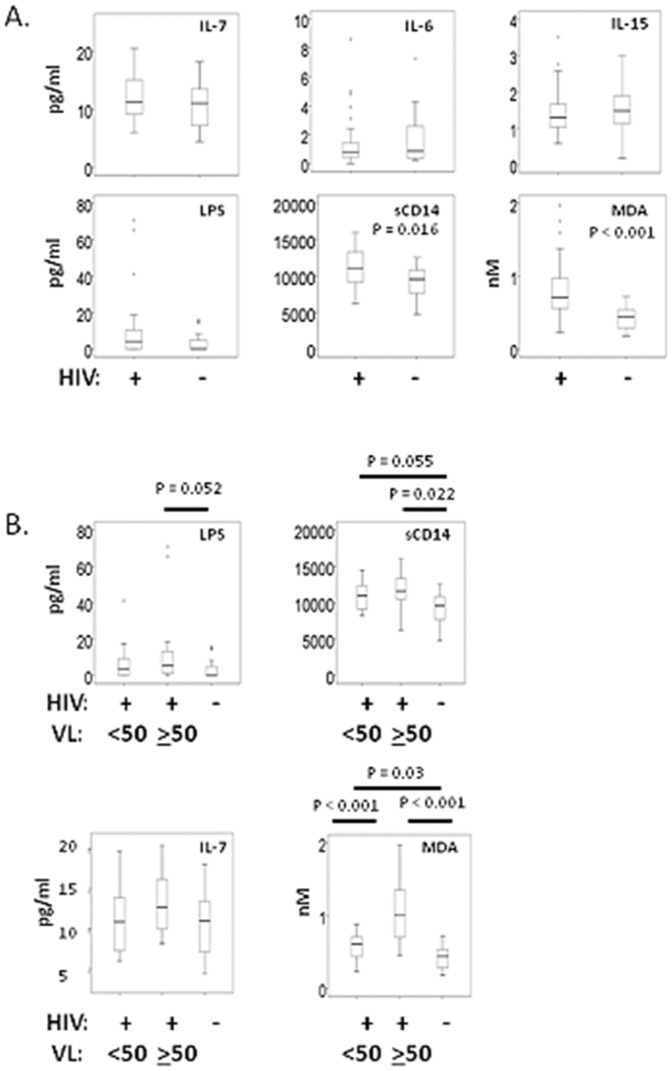
Increased sCD14 and MDA adducts in serum of HIV+ donors.Serum samples from HIV+ and HIV- donors were stored at −80°C until analyzed in batch with commercial ELISA kits. Data are shown comparing cytokine levels in all HIV+ donors to controls (A) or comparing viremic, aviremic and controls (B). Statistical significance was determined by Mann Whitney tests (A) or by Kruskal-Wallis Test for multi-group analysis and Mann Whitney (B).